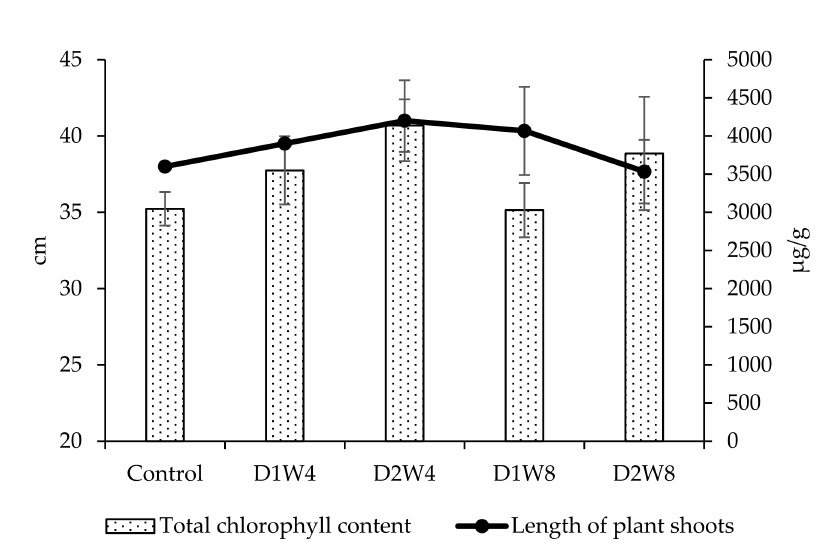
Figure 9. Changes in total chlorophyll content and plant shoot length of Arenosol soil. The codes are as follows: D1W4: Dose 1 Week 4. D2W4: Dose 2 Week 4. D1W8: Dose 1 Week 8. D2W8: Dose 2 Week 8.